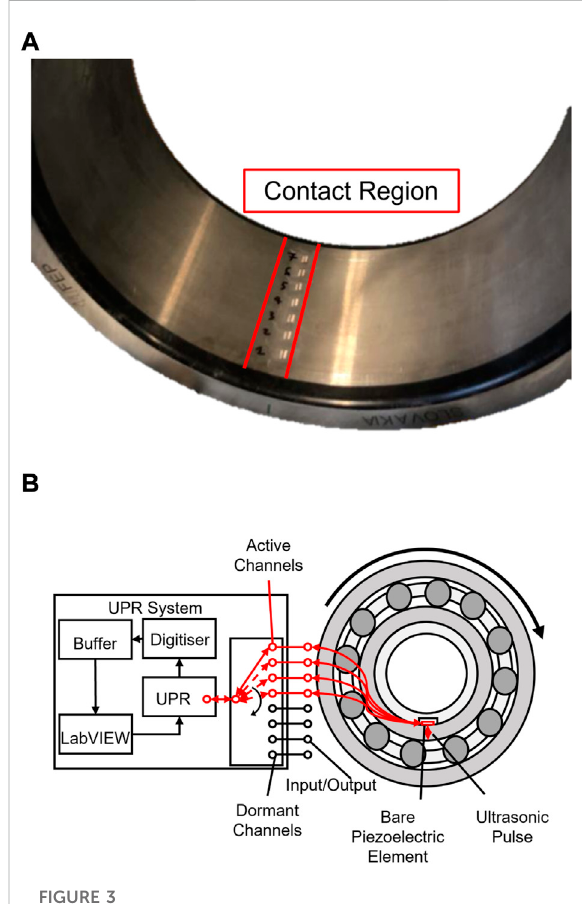
FIGURE 3 (A) Roller bearing inner raceway with a row of